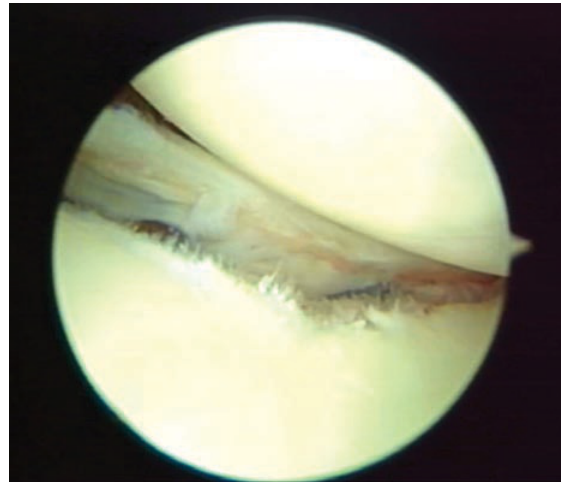
Figure 2. Labral fraying due to chronic glenohumeral instability.